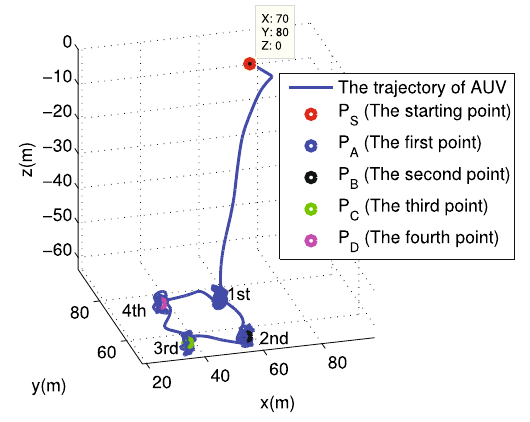
Fig. 6 AUV 3D position trajectory of the proposed controller utiliz- ing the non-allowable measurement delay